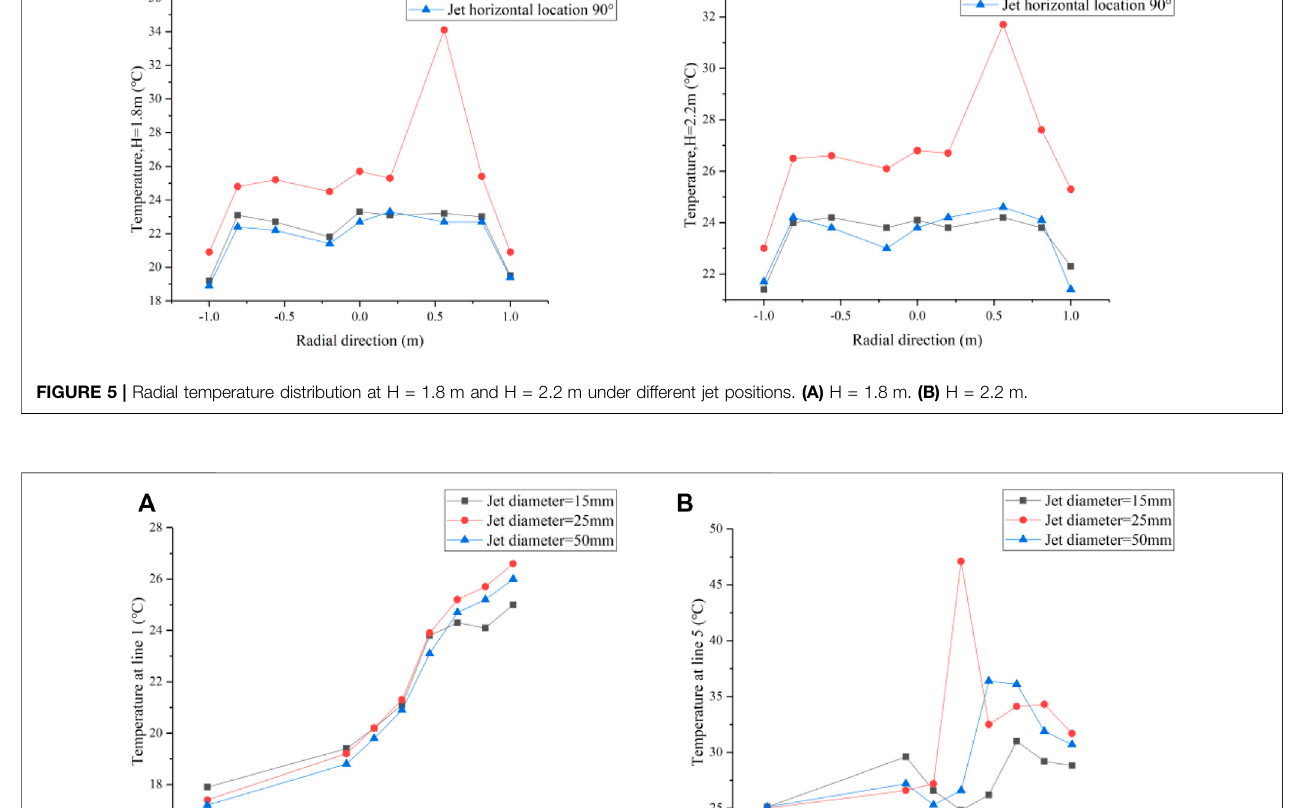
Figure 8 . A jet size of 25 mm was taken as an example to